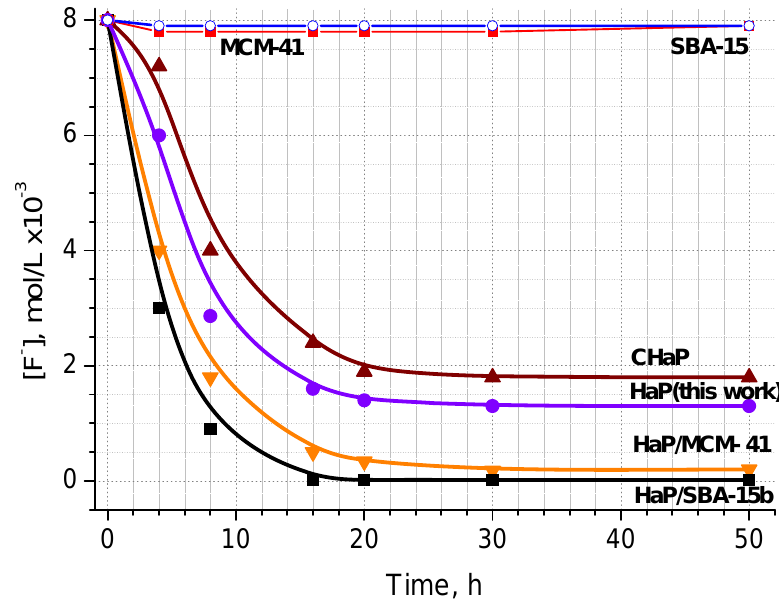
Figure 7. F - retention capacity from contaminated water of the samples vs. time.